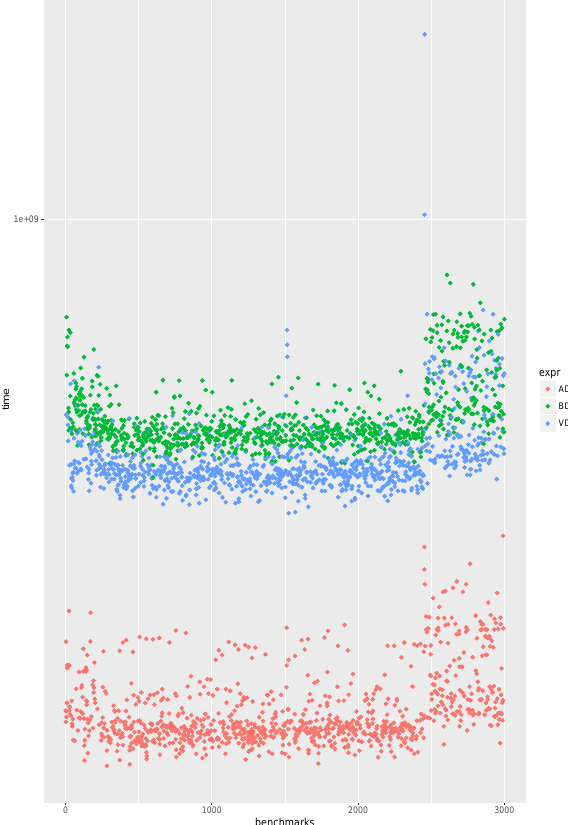
Figure 4. Computation benchmark